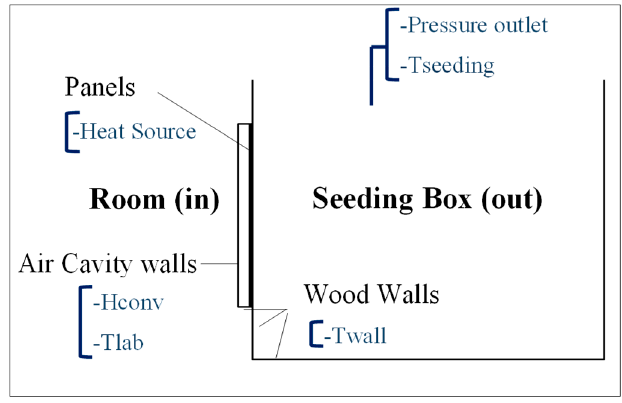
Figure 5. Boundary conditions scheme of the OJVF.